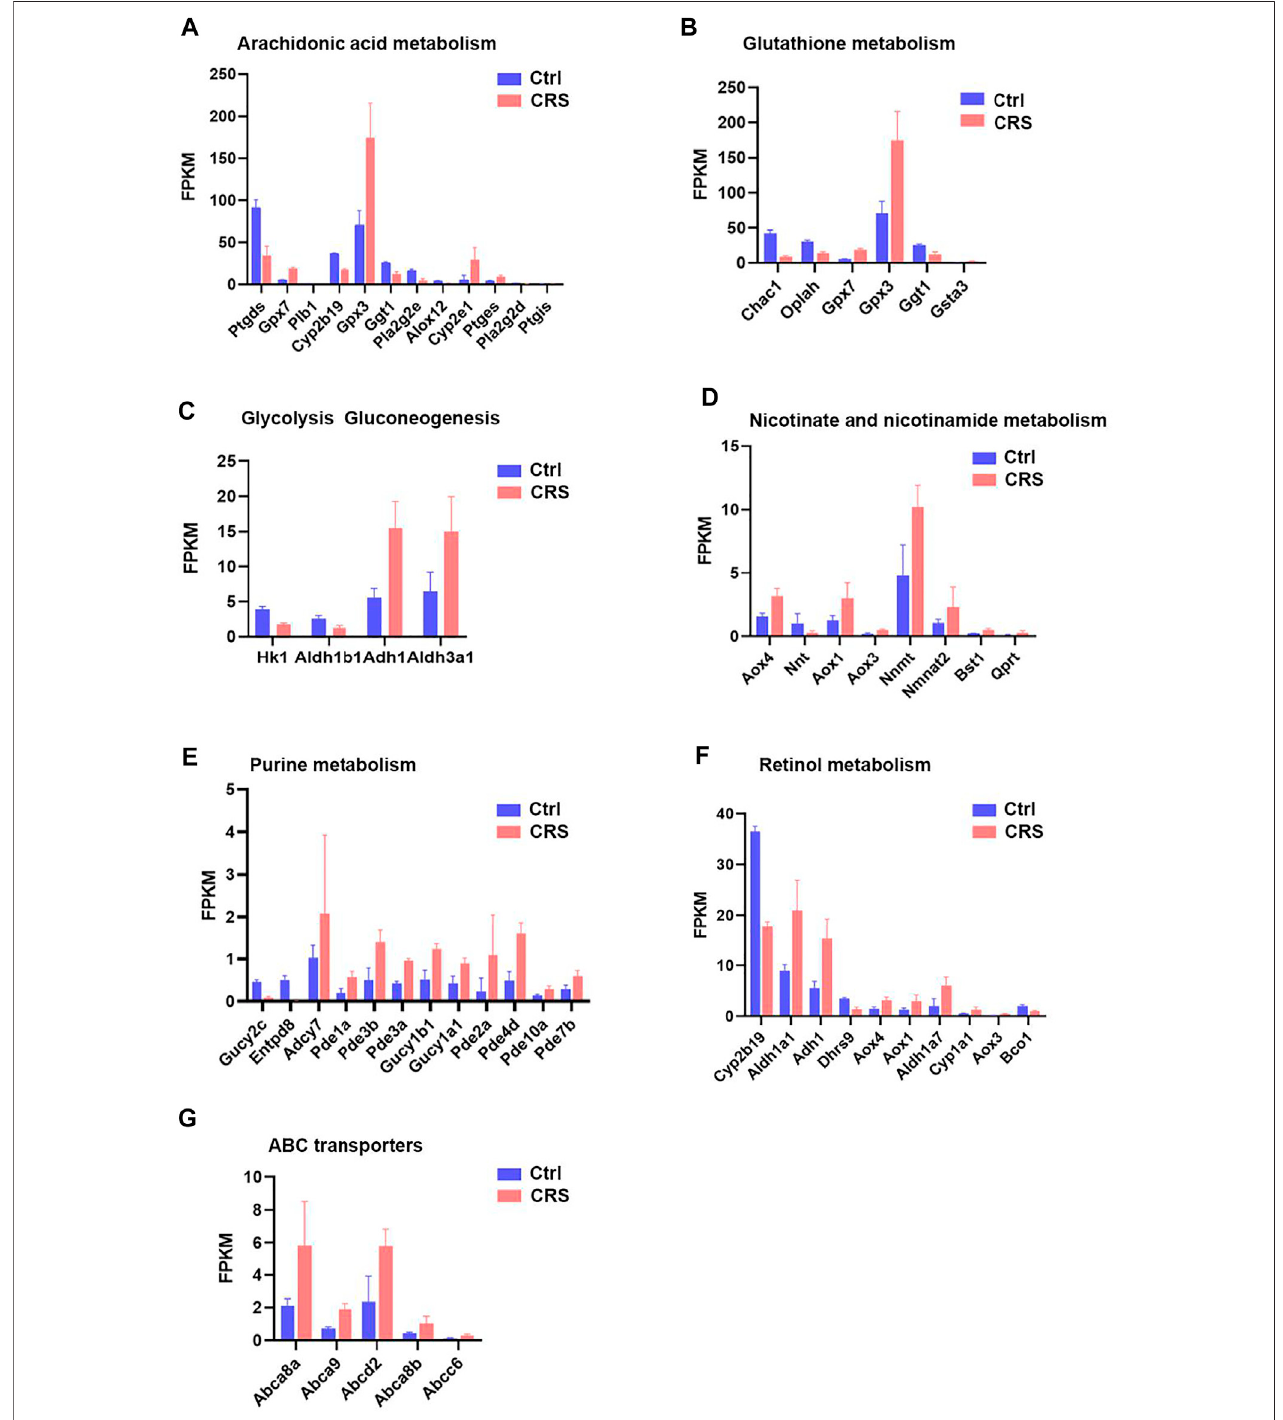
FIGURE 8 | CRS signi fi cantly alters genes expression related to metabolism pathways based on RNA-seq. (A) The FPKM values of DEGs associated with arachidonic acid metabolism between CRS group and control group. (B) The FPKM values of DEGs associated with glutathione metabolism between CRS group and control group. (C) The FPKM values of DEGs associated with glycolysis gluconeogenesis between CRS group and control group. (D) The FPKM values of DEGs associatedwithnicotinateandnicotinamidemetabolismbetweenCRSgroupandcontrolgroup. (E) TheFPKMvaluesofDEGsassociatedwithpurinemetabolism betweenCRS groupand controlgroup. (F) TheFPKM valuesofDEGs associated withretinolmetabolism between CRSgroup and controlgroup. (G) TheFPKM values of DEGs associated with ABC transporters between CRS group and control group.